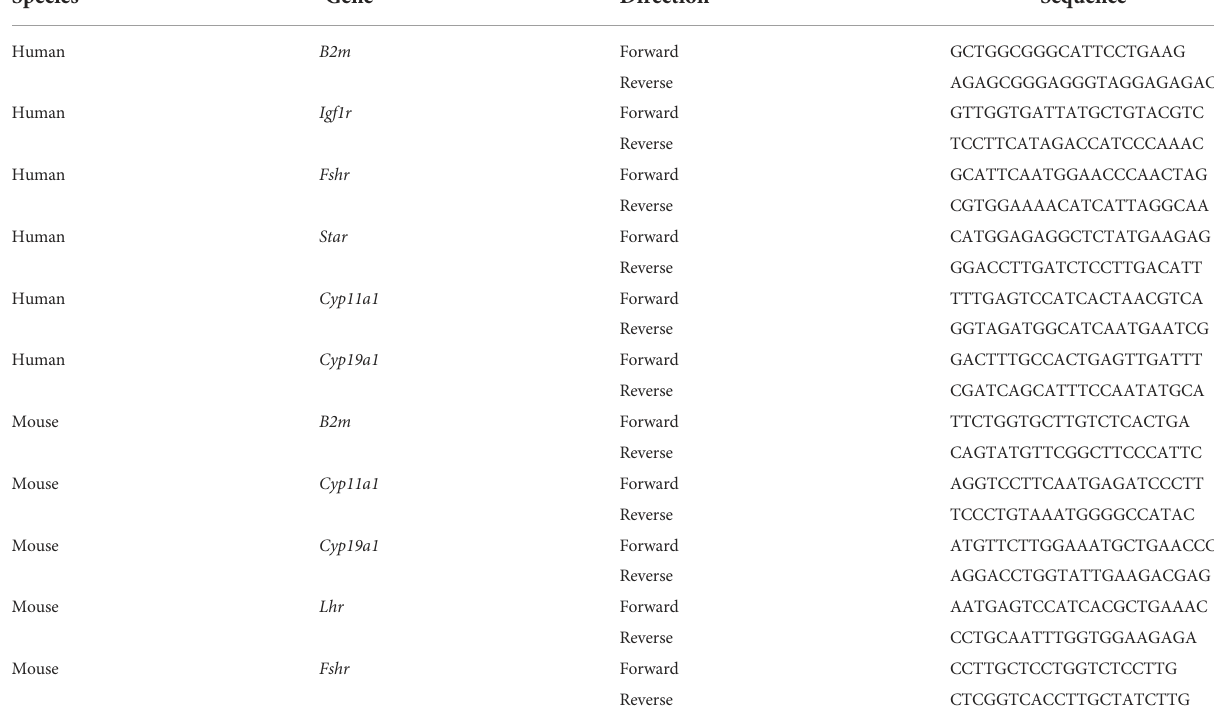
TABLE 1 Primer sequences of target